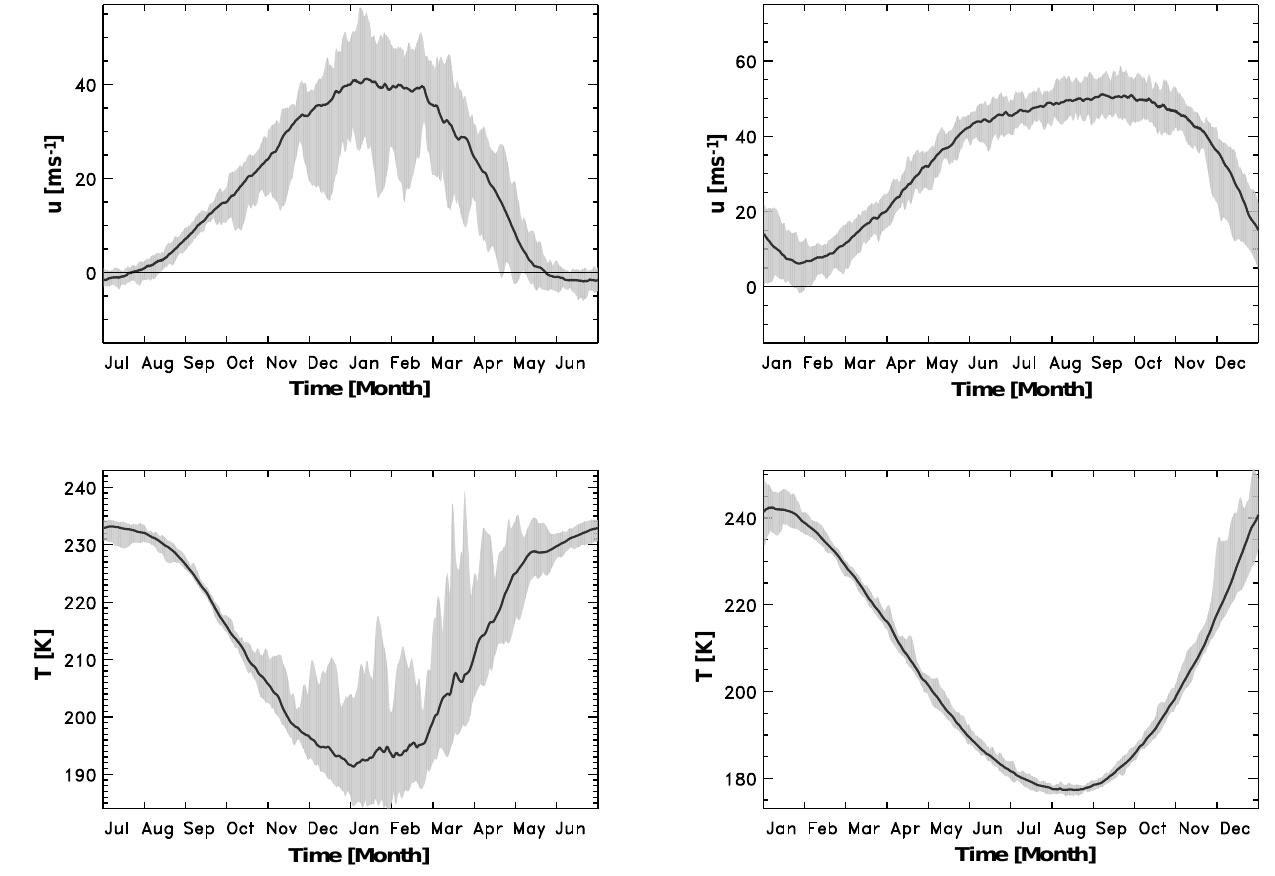
Fig. 16. Modeled zonal mean zonal wind at 60 ◦ N, 30 hPa (upper left panel), at 60 ◦ S, 30 hPa (upper right panel), and zonal mean temperature at 80 ◦ N, 30 hPa (lower left panel), and 80 ◦ S, 30 hPa (lower right panel) from a sensitivity simulation applying the ECHAM4/CHEM model in standard L19 vertical resolution. Model data are averaged over 20 simulated years. Shaded areas indicate the interannual variability (minimum to